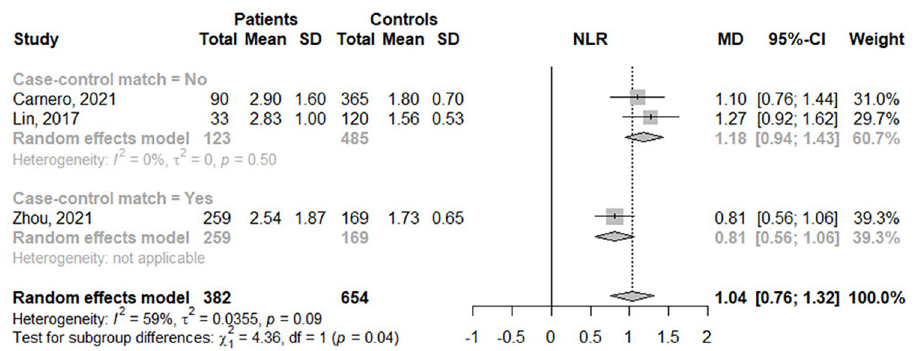
Fig 2. Mean difference in the neutrophil-to-lymphocyte ratio (NLR) between NMOSD patients and healthy controls according to reported match.